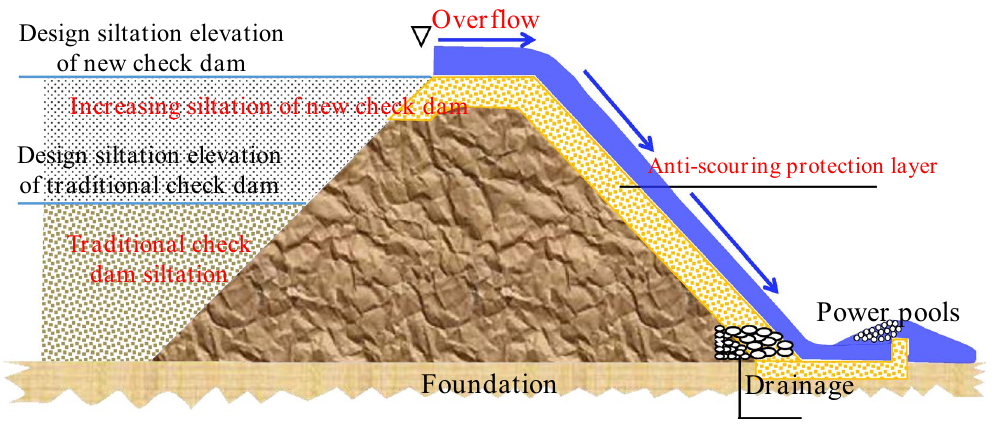
Figure 5. Schematic diagram of the new high-standard check